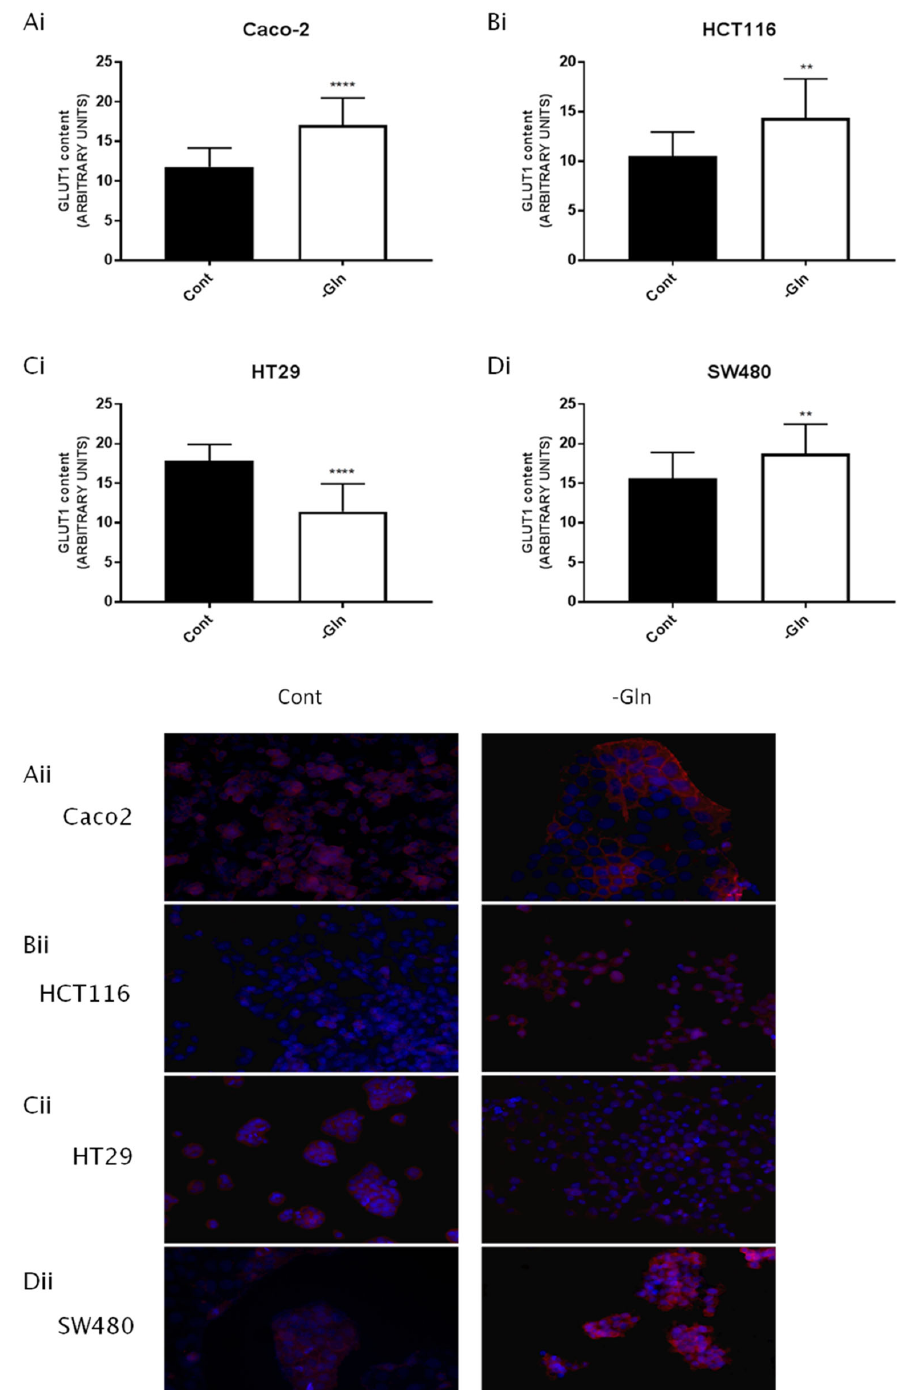
Figure 6. Glutamine starvation altered the expression of glucose transporter GLUT1. Quantification of immune fluorescent pattern in the colorectal cancer cell lines after 48h of glutamine deprivation (-Gln) and relative controls (Cont). ( Ai ) Caco-2, ( Bi ) HCT116, ( Ci ) HT29, ( Di ) SW480. Data are shown as percentage of control. Statistical analysis was performed by Student t -test. The experiment was performed in triplicate and represented mean ± SD ( n = 3, ** p < 0.005, **** p < 0.0001 compared to Cont). ( Aii ) Caco-2, ( Bii ) HCT116, ( Cii ) HT29, ( Dii ) SW480 microphotographs (Scale bar = 10 µ m, magnification = 20 × ) of colorectal cancer cells with GLUT1 stained in red and nuclei stained with DAPI in